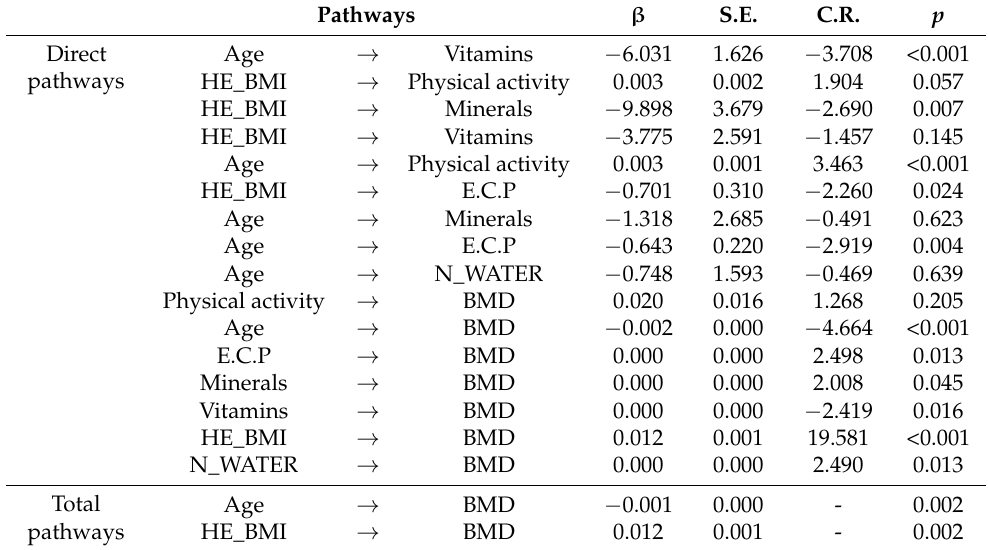
Table 5. Results of direct and total pathways in premenopausal women with bone mineral density.